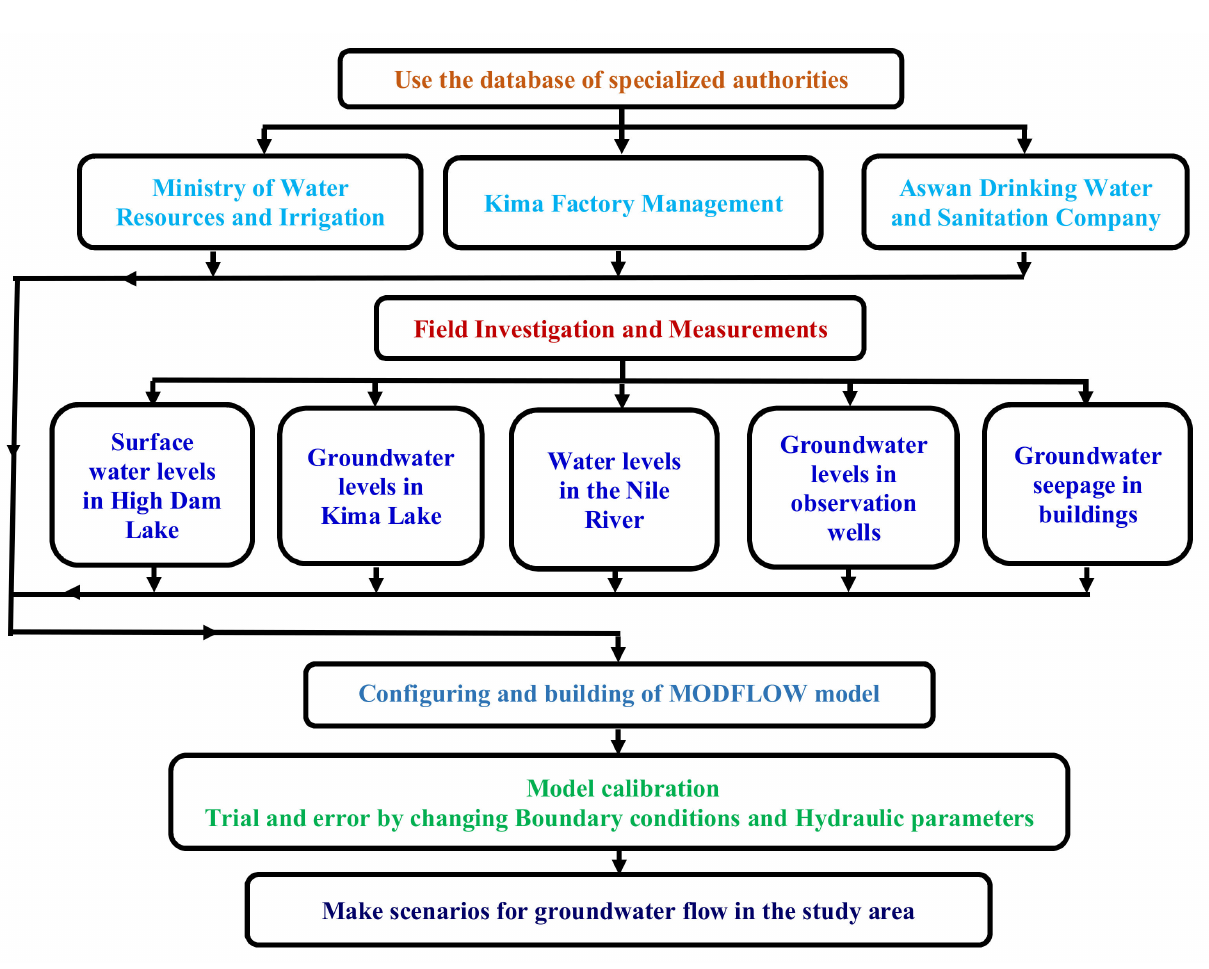
Figure 2. Flowchart of the optimum management methodology for the groundwater